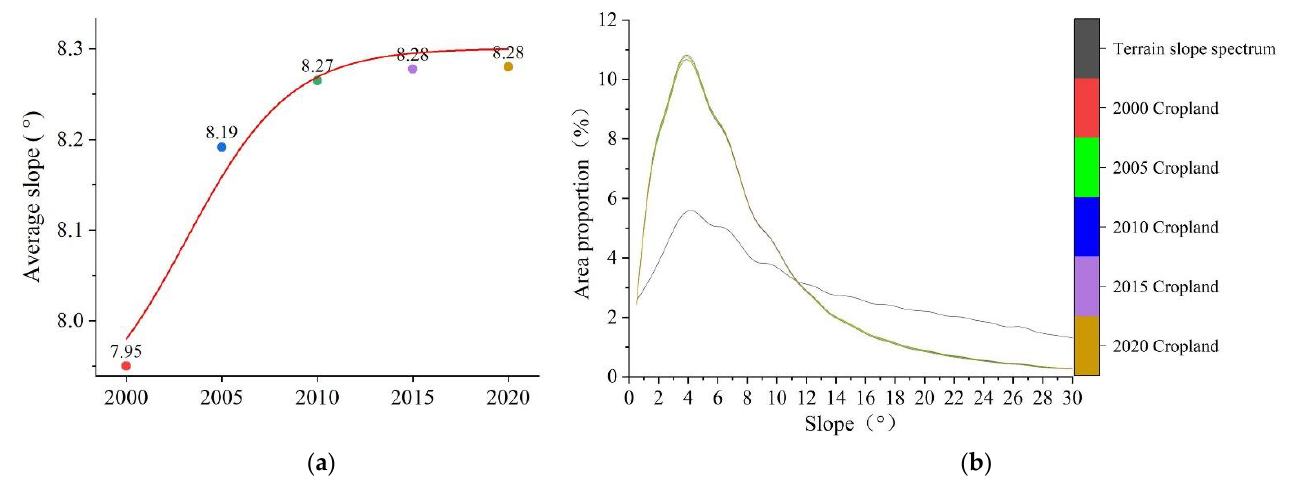
Figure 6. Average slopes and slope spectrum of cropland in the MRYRR in 2000 – 2020. ( a ) Changes in the average slopes of sloping cropland in 2000 – 2020. ( b ) Slope spectrum of cropland in 2000 – 2020.